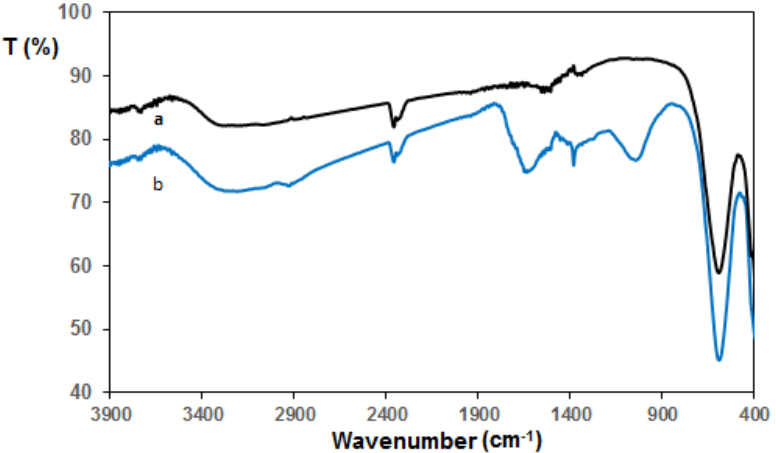
Fig. 1. FT-IR spectra of NiFe 2 O 4 (a) and Pd/NiFe 2 O 4 (b).